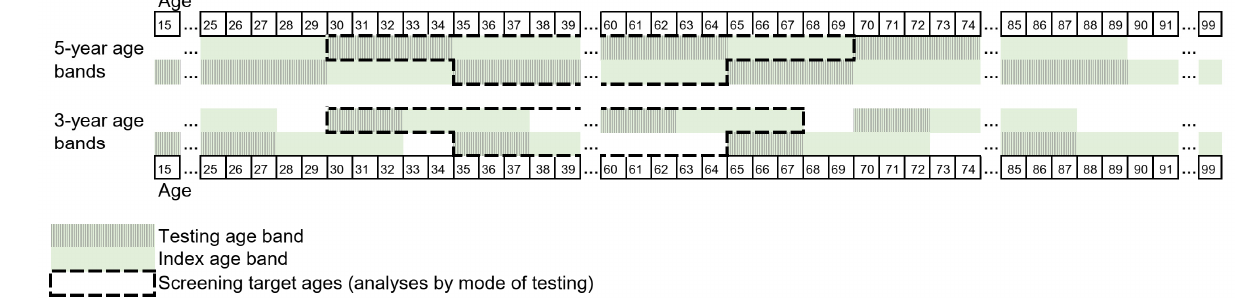
Figure 1. Definition of testing and index age bands. Testing in five- and three-year age bands against cervical cancers in the following five-year interval were examined. For example, for the five-year testing age bands, association between testing of women at ages 30 to 34 and cancers in women at ages 35 to 39 were examined. Note: those tests that occurred in the index age band (35 to 39) before the possible diagnosis were not considered. In the mode-specific analysis, only tests taken at the target ages of the national screening program (ages 30 to 64) were included: i.e., index ages of 35 to 69 and 33 to 67.